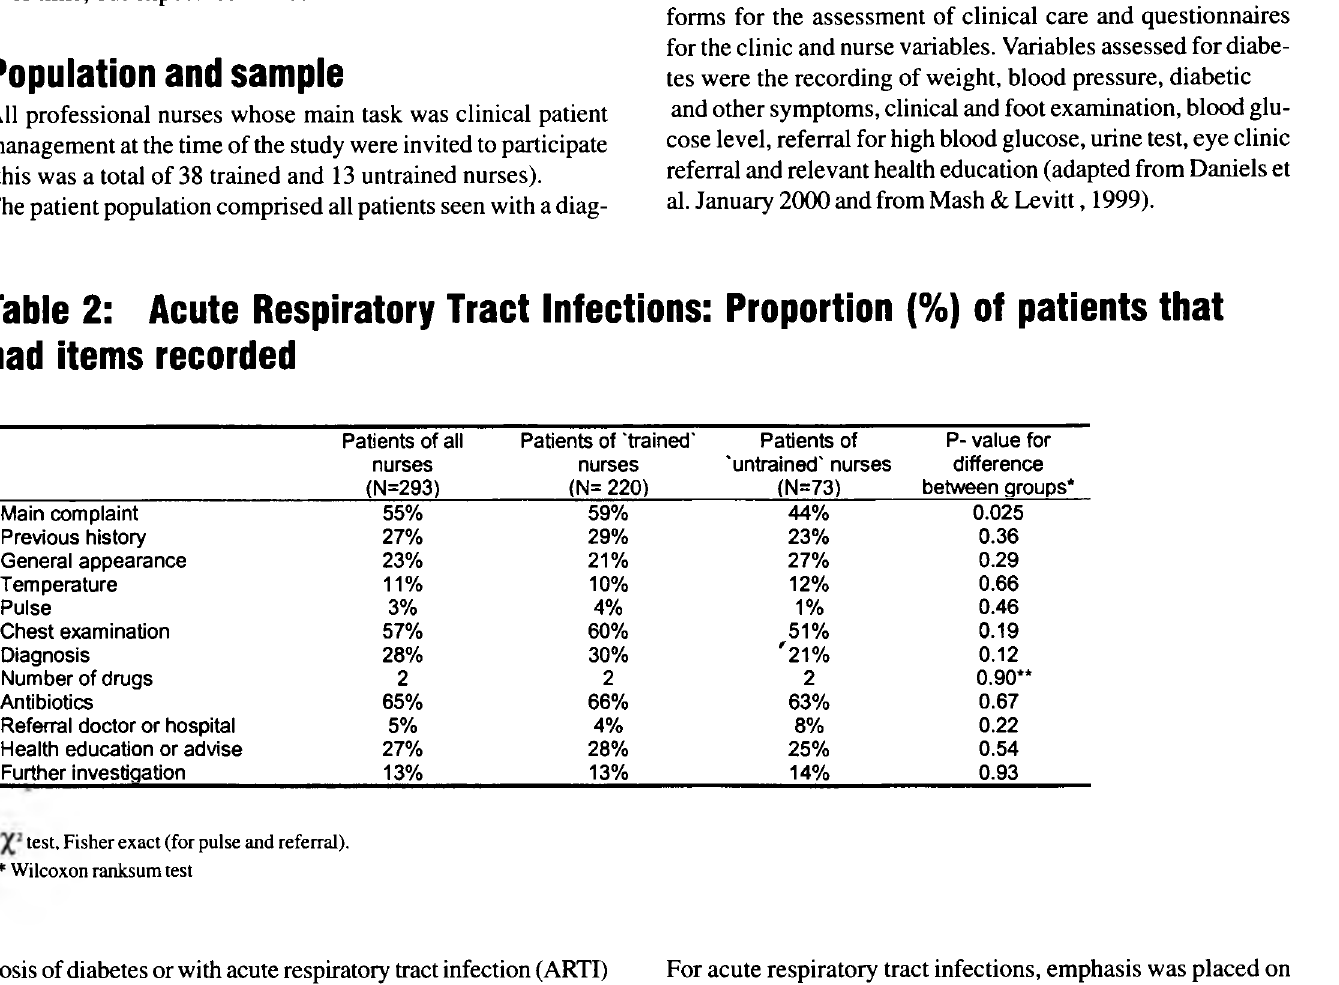
Acute Respiratory Tract Infections: Proportion (% ) of patients that had items